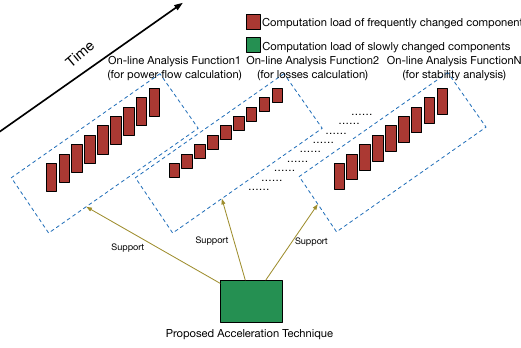
Figure 2. Computation load of the power system analysis